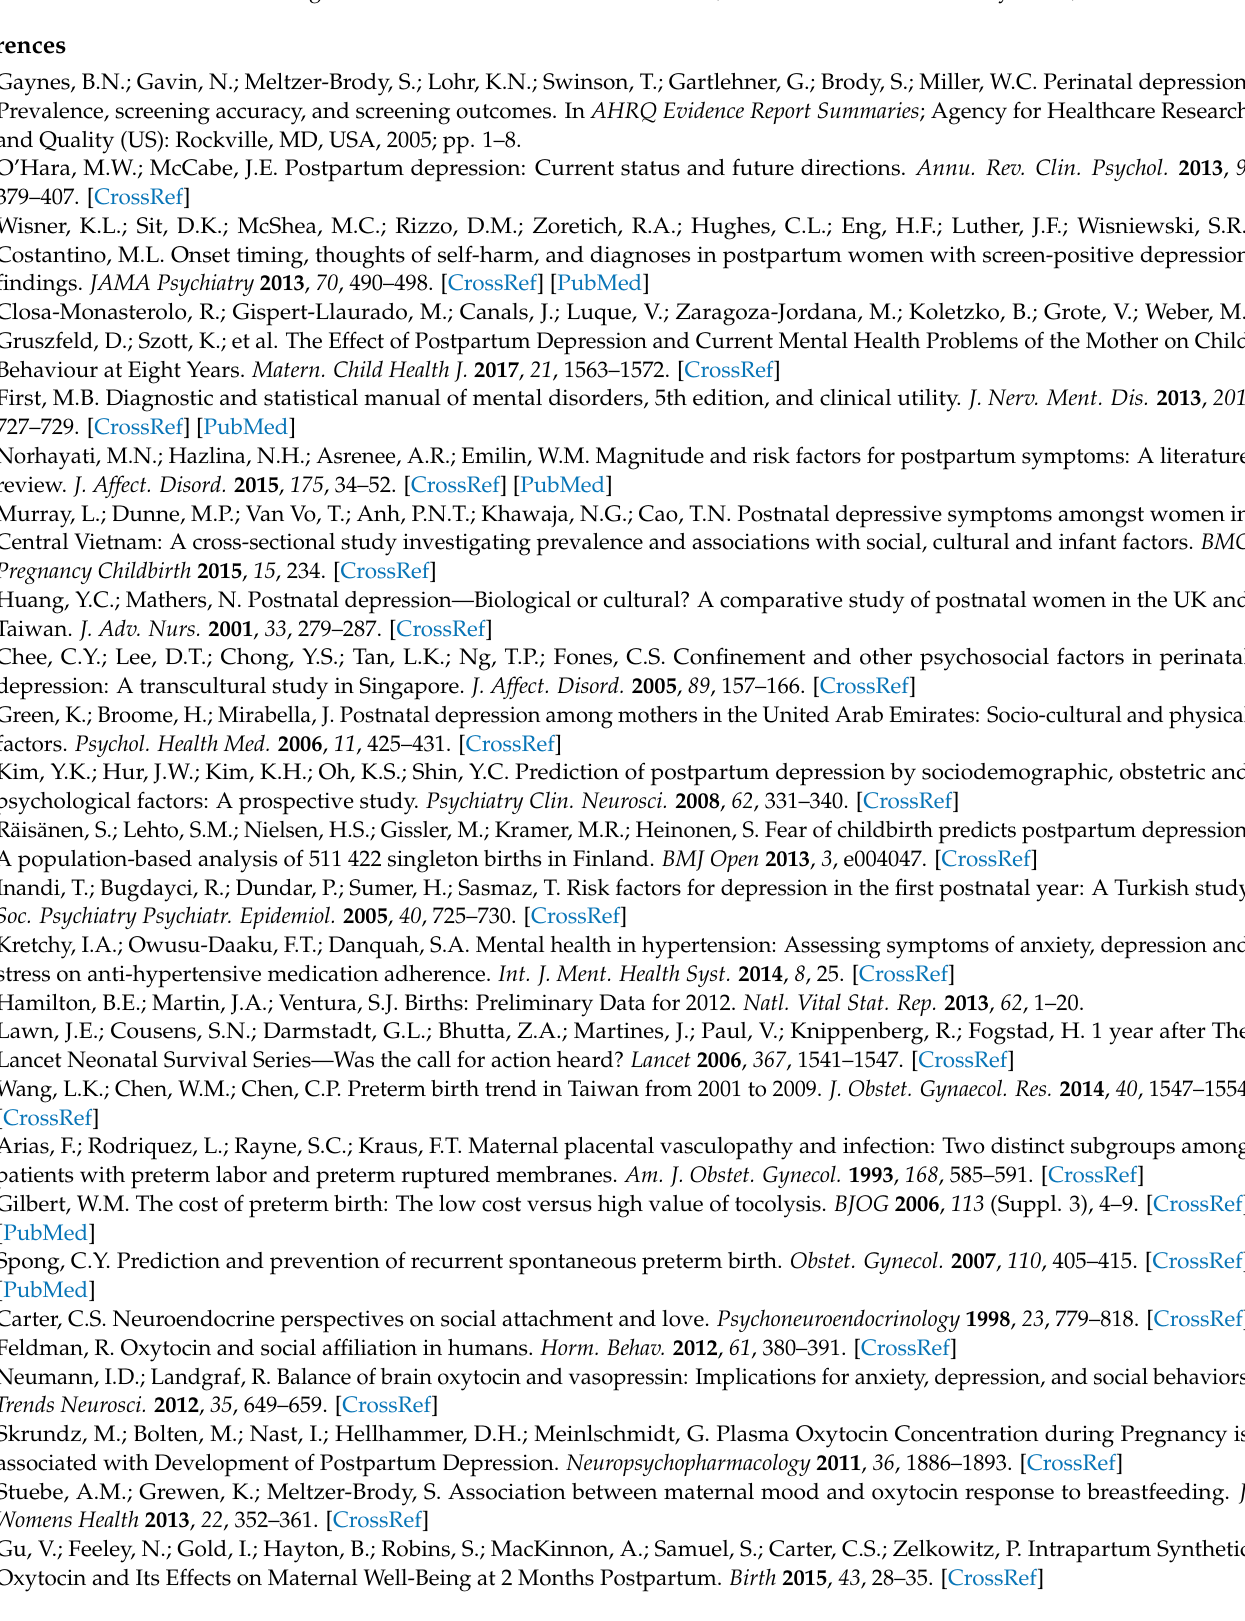
PPD = postpartum depression, ICD-9-CM = International Classification of Diseases, 9th Revi- sion, Clinical Modification, NHIRD = National Health Insurance Research Database, LHID2000 = Longitudinal Health Insurance Database2000, CCI = Charlson comorbidity index, OR = odds